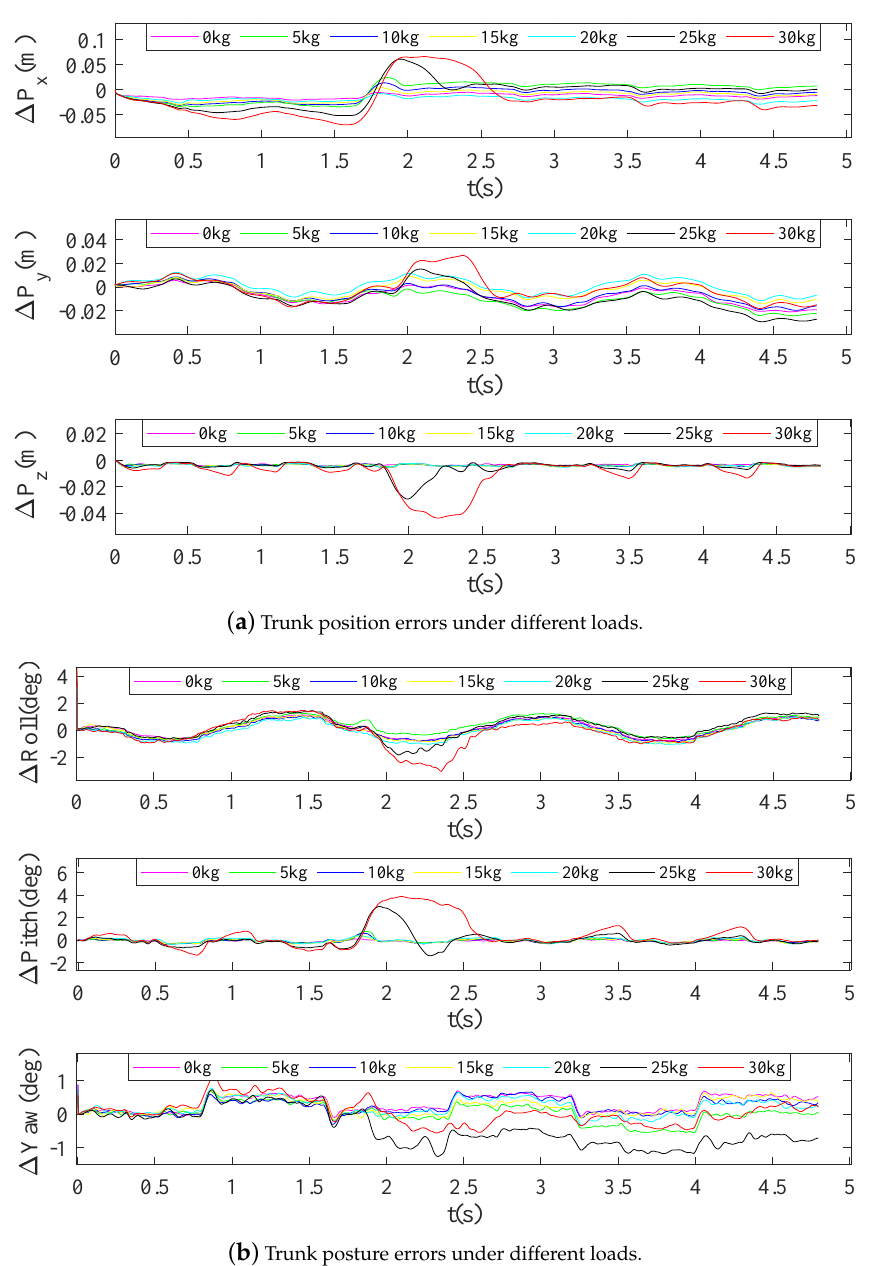
( b ) Trunk posture errors under different loads. Figure 13. Trunk position errors and posture errors under different loads at the speed of 0.68